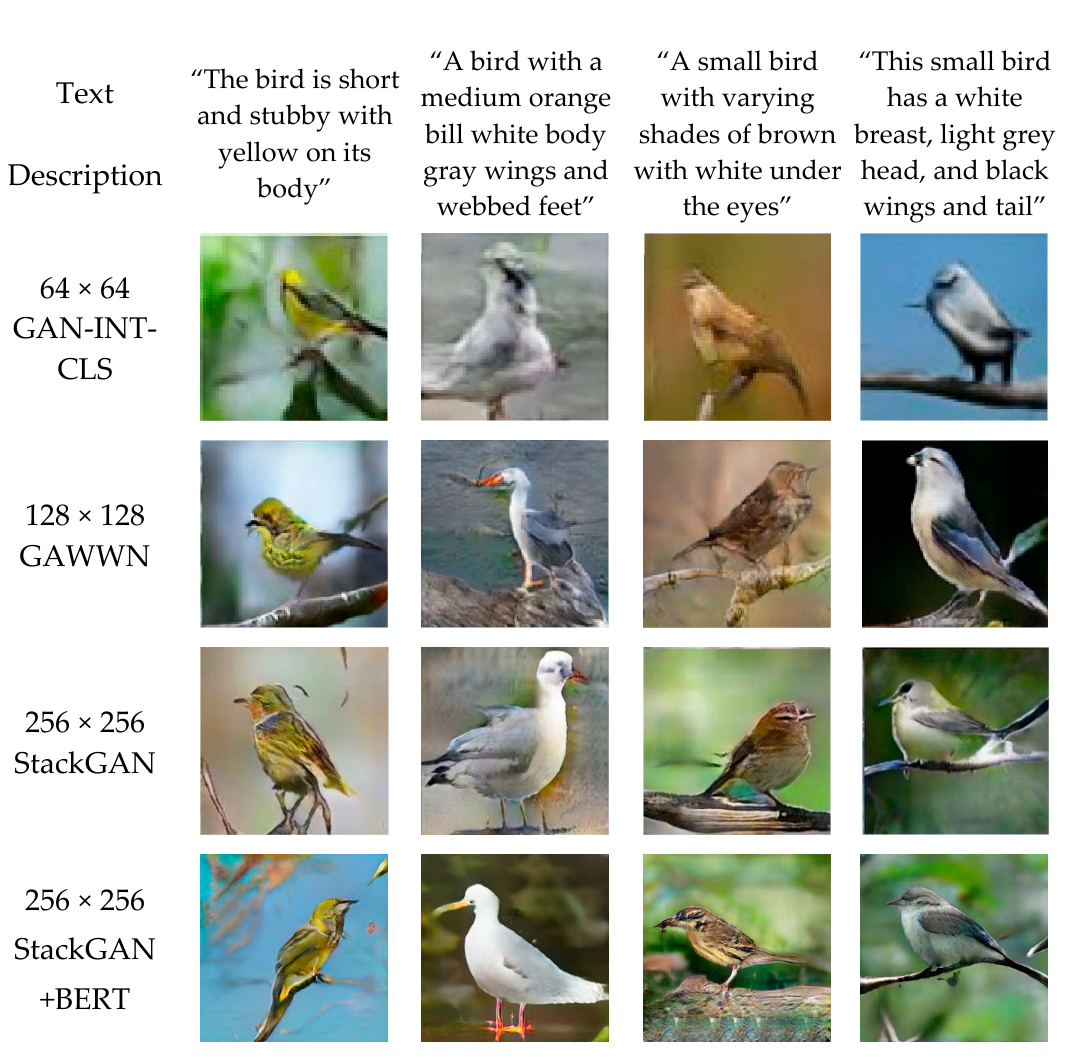
Figure 2. Qualitative Results on CUB.